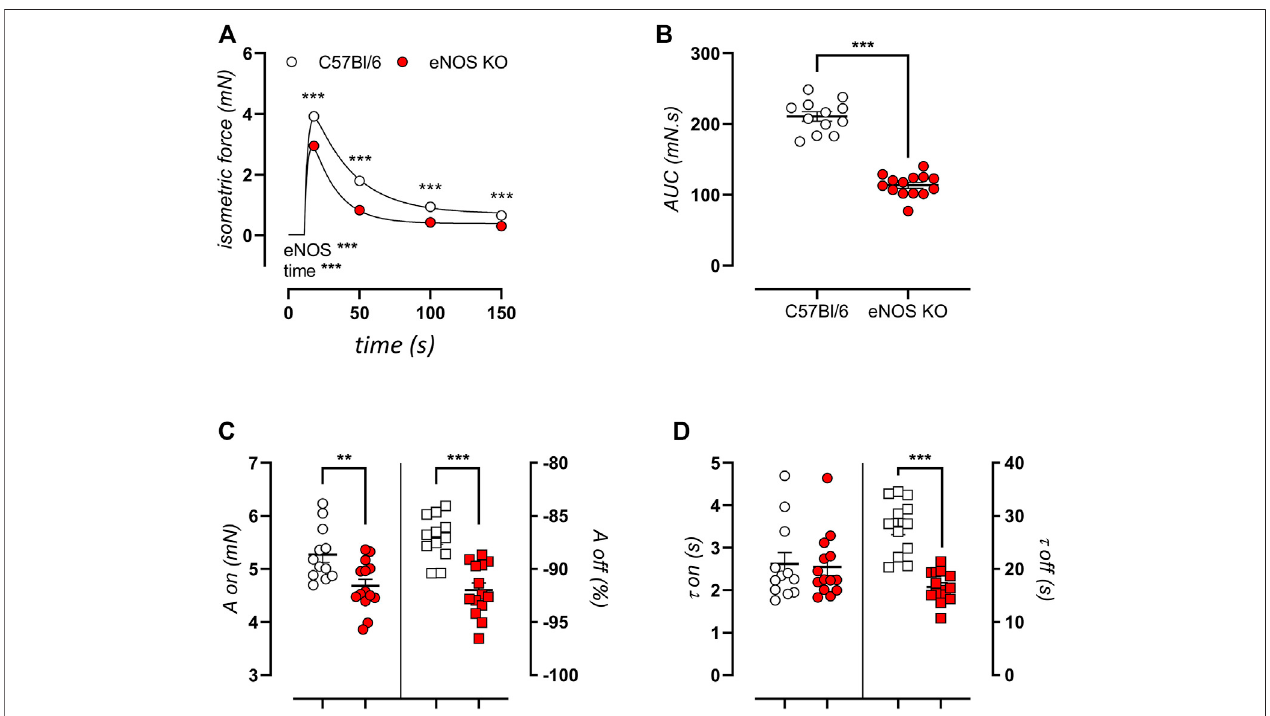
FIGURE 7 | eNOS knockout mice display smaller SR-medicated isometric contractions. Transient SR-mediated contractions were studied in 6-month old eNOS knockout ( n = 14) and C57Bl/6 control ( n = 12) mice by stimulation with 2 μ M PE in a calcium-free extracellular environment (0Ca Krebs). Presented results are the averageoftwoaortic segments per mousestudied inparallel. Atracingofthecontraction (A) and calculatedareaunderthecurve (B) areshown.Bi-exponential fi ttingof theupward(on)anddownward(off)phasesofthecontractionwasusedtocalculatetheamplitude(A) (C) andtimeconstant( τ ) (D) ofbothphases.Theamplitudeof the downward phase (A off ) was calculated as the relative relaxation as compared to the amplitude of the upward phase (A on ). Statistical analysis was preformed using two-way ANOVA (A) or student t -test (B – D) . Overall signi fi cance (bottom left) and post-hoc signi fi cance (in graph) are listed. **, p < 0.01; ***, p < 0.001.